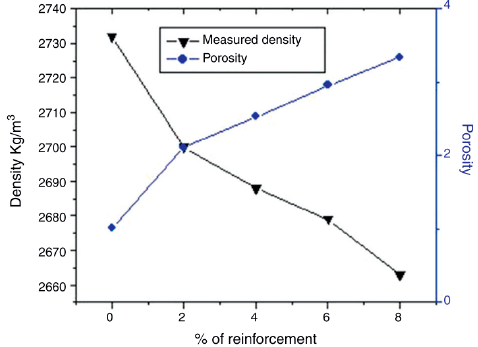
Figure 11. Variation in density and porosity with % wt of reinforcement [85].